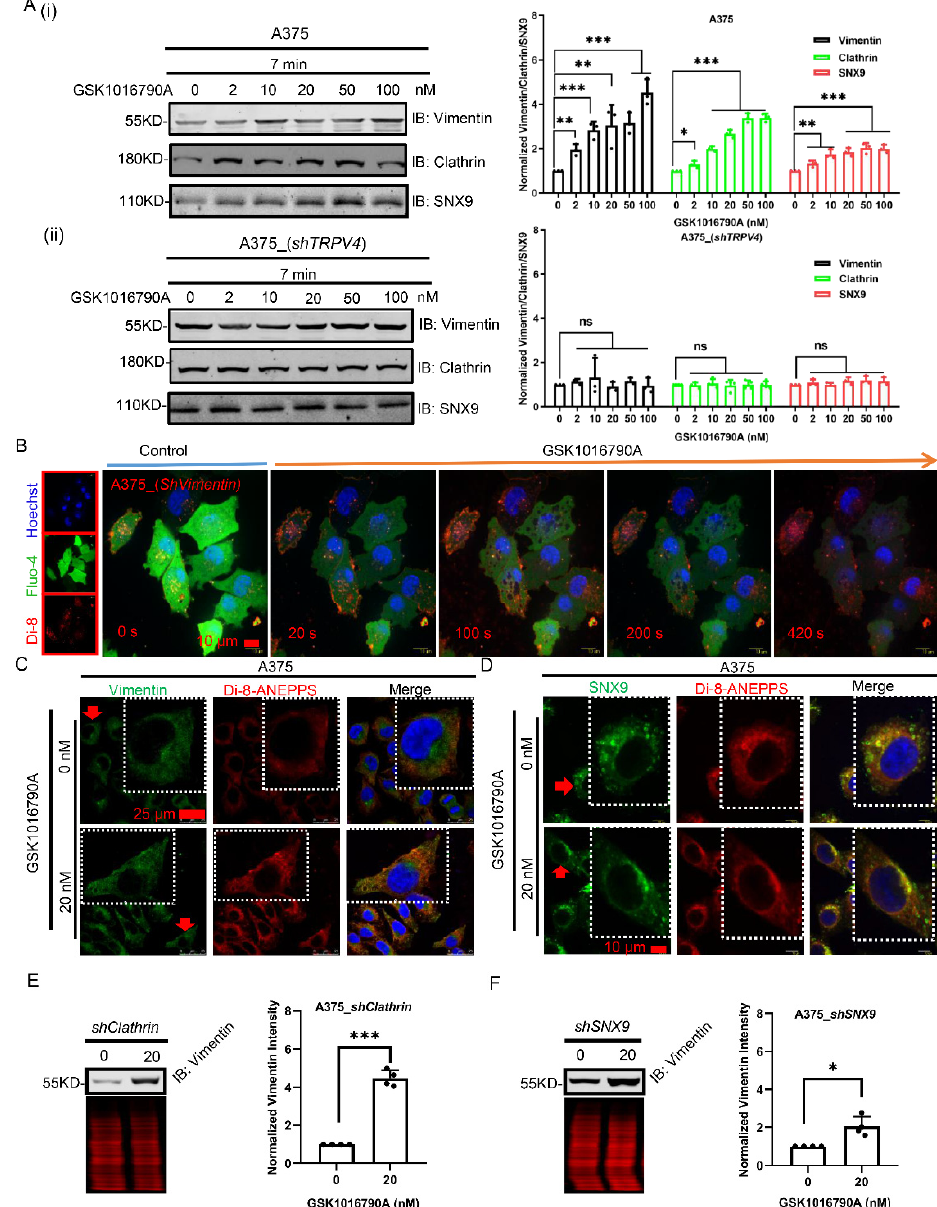
Figure 6 . The interplay among vimentin/clathrin/SNX9 aids vesicles transduction of exocytosis. ( A ) Western blot of A375 and A375 with suppression of TRPV4 (upon GSK1016790A by concentration gradient) cell lysates probed for vimentin, clathrin (heavy chain), and SNX9, respectively. Target protein quantification was normalized to total protein. ( B ) Time-lapse of scanning disk confocal images of A375 cells with vimentin knock-down with GSK1016790A (20 nM) administration. Scale bar, 10 μ m. ( C ) Confocal microscopic images of A375 cells treated with or without GSK1016790A (20 nM) immunostained for vimentin. Scale bar, 25 μ m. ( D ) Confocal spanning disk microscopic images of A375 cells treated with or without GSK1016790A (20 nM) immunostained for SNX9. Scale bar, 10 μ m. Western blot of A375 with ( E ) shclathrin and ( F ) shSNX9 (upon GSK1016790A (20 nM) stimuli) cell lysates probed for vimentin. Target protein quantification was normalized to total protein. Data are presented as mean ± SD of at least three independent experiments, t -test, * p < 0.05, ** p < 0.01, *** p < 0.001, ns indicates no significance.